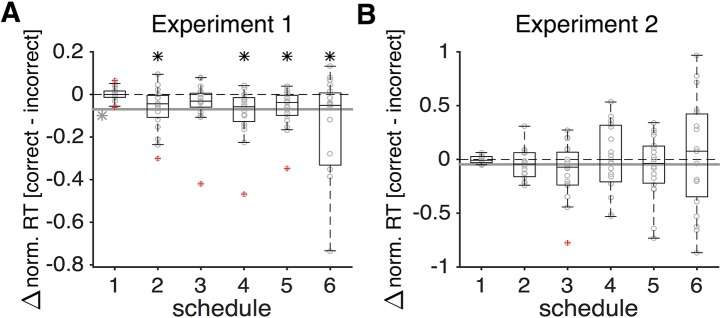
Response time was shorter on correct than incorrect trials in Experiment 1 but not in Experiment 2.(A) Plotted is the difference in normalized RT between correct and incorrect trials across all subjects in Experiment 1. The solid gray line shows the average difference over all schedules, and the gray asterisk next to it indicates that this difference was significantly different from 0 (two-sided sign test, p < 0.05). Each black asterisk shows that the difference in RT between correct and incorrect trials for a given schedule was significantly different from 0 (two-sided sign test, p < 0.05), and the outliers are indicated by circles with red crosses. (B) The same as in (A) but for Experiment 2. In Experiment 2, the difference in the normalized RT between correct and incorrect trials was not different from 0 in any schedule or in the average data.